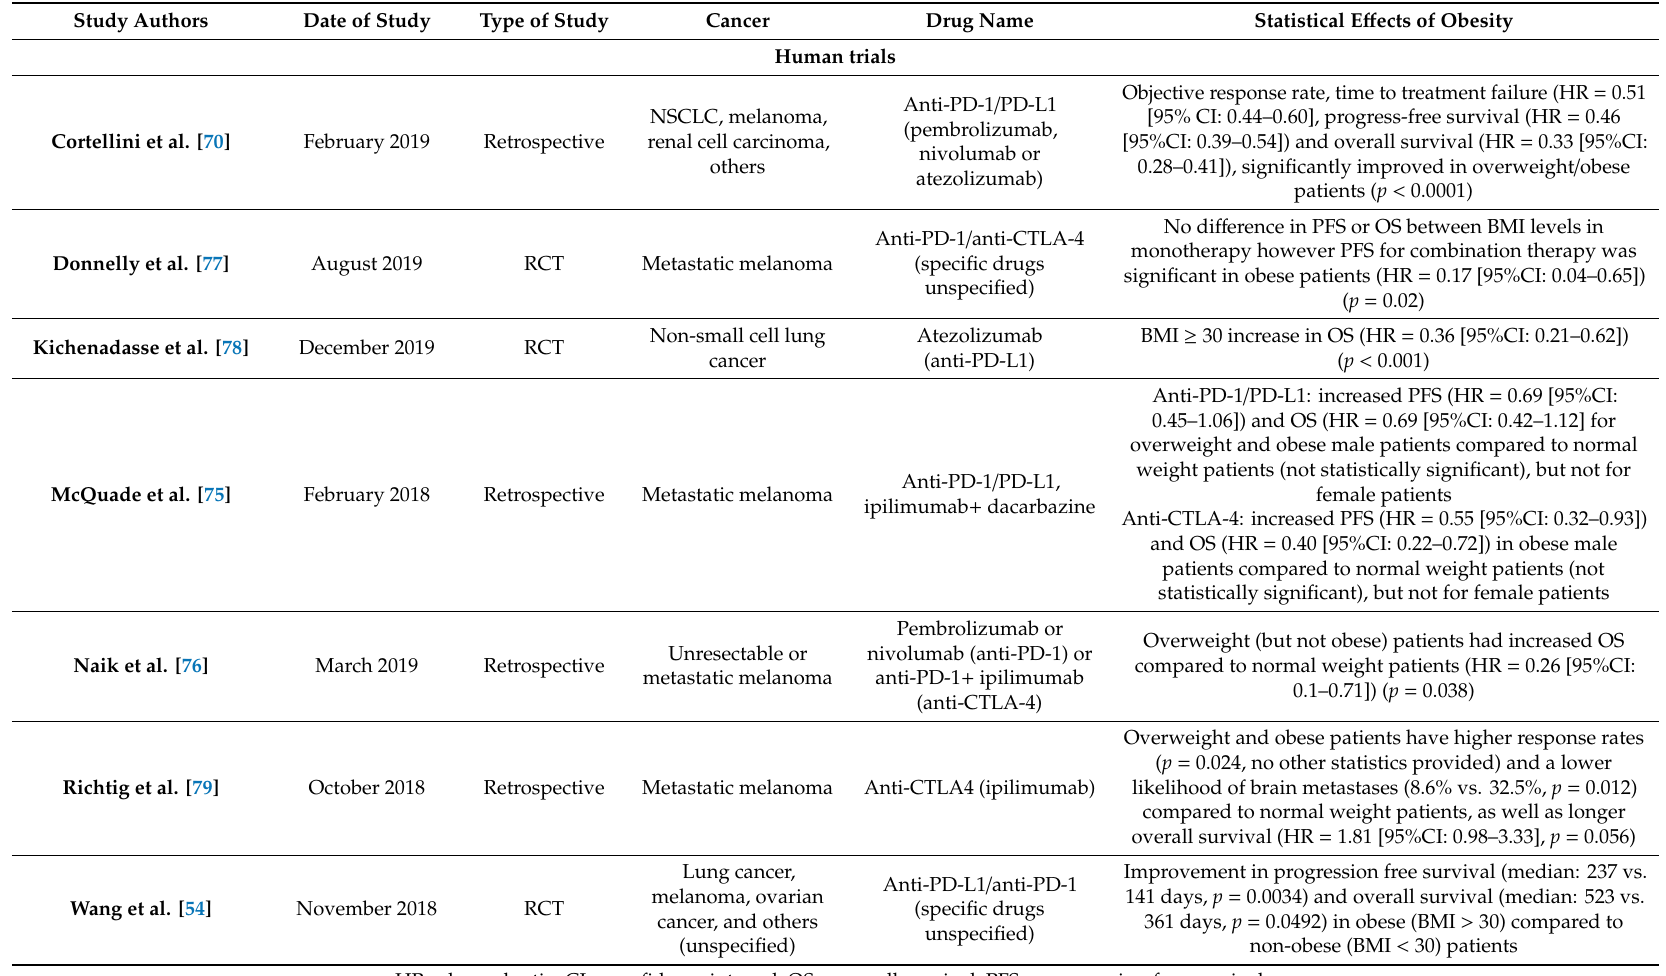
Table 1. Human studies published before February 2020 investigating the e ff ects of obesity on immune checkpoint blockade therapy for